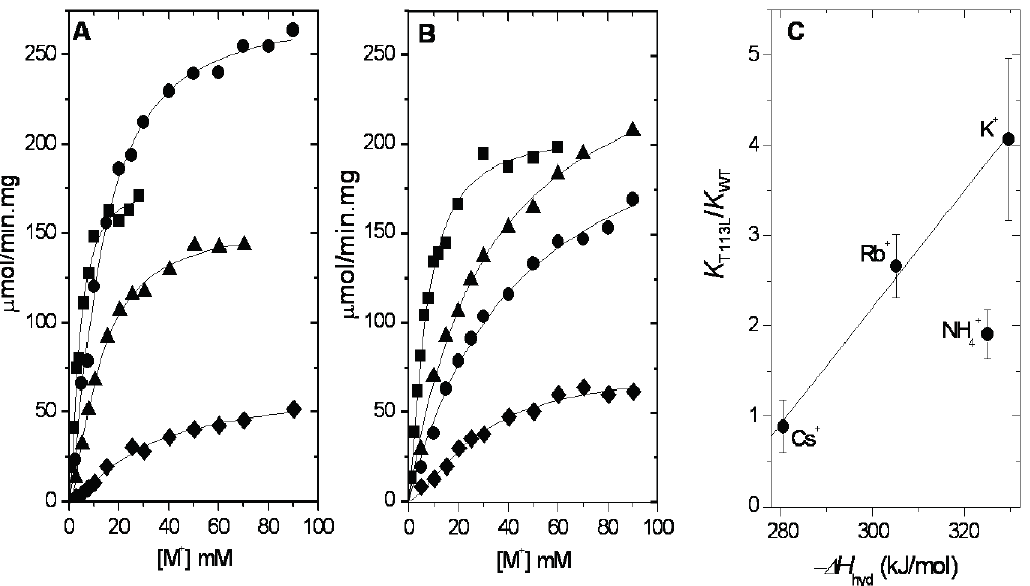
Figure 2. Activation of WT-RMPK ( A ) and T113L-RMPK ( B ) by K + ( ● ), NH 4+ ( ■ ), Rb + ( ▲ ) or Cs + ( ♦ ) at saturating PEP 3 − and ADP-Mg complex in 100% water; ( C ) K T113L / K WT ratios for the indicated monovalent cations against their heats of dehydration. The activities in the presence of the indicated concentrations of monovalent cations were measured. The